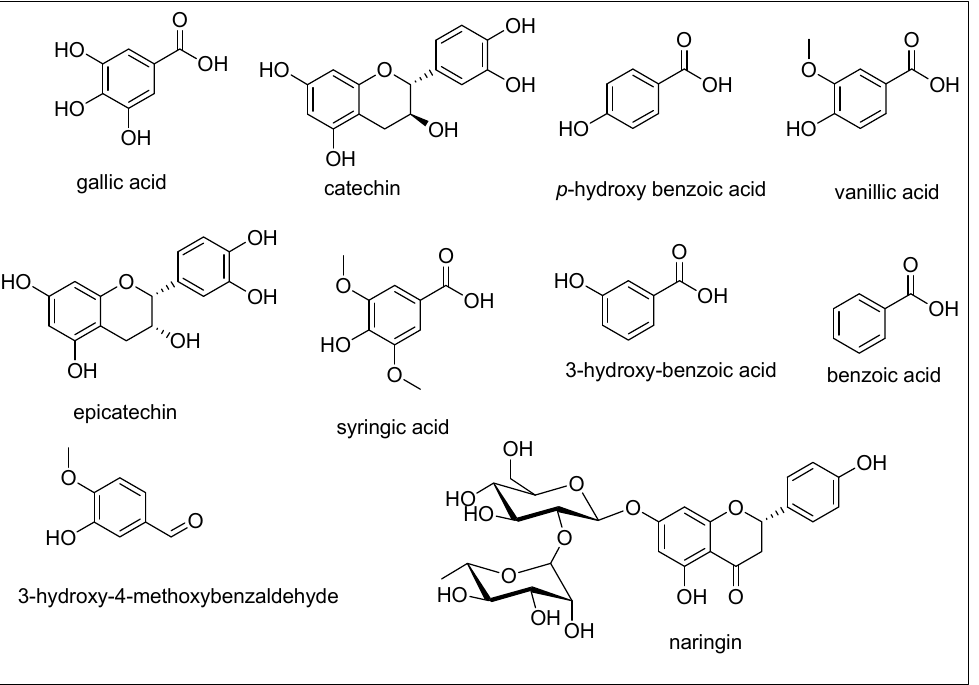
Figure 1. Phenolic compounds quantified in different extracts of B. papillosa .